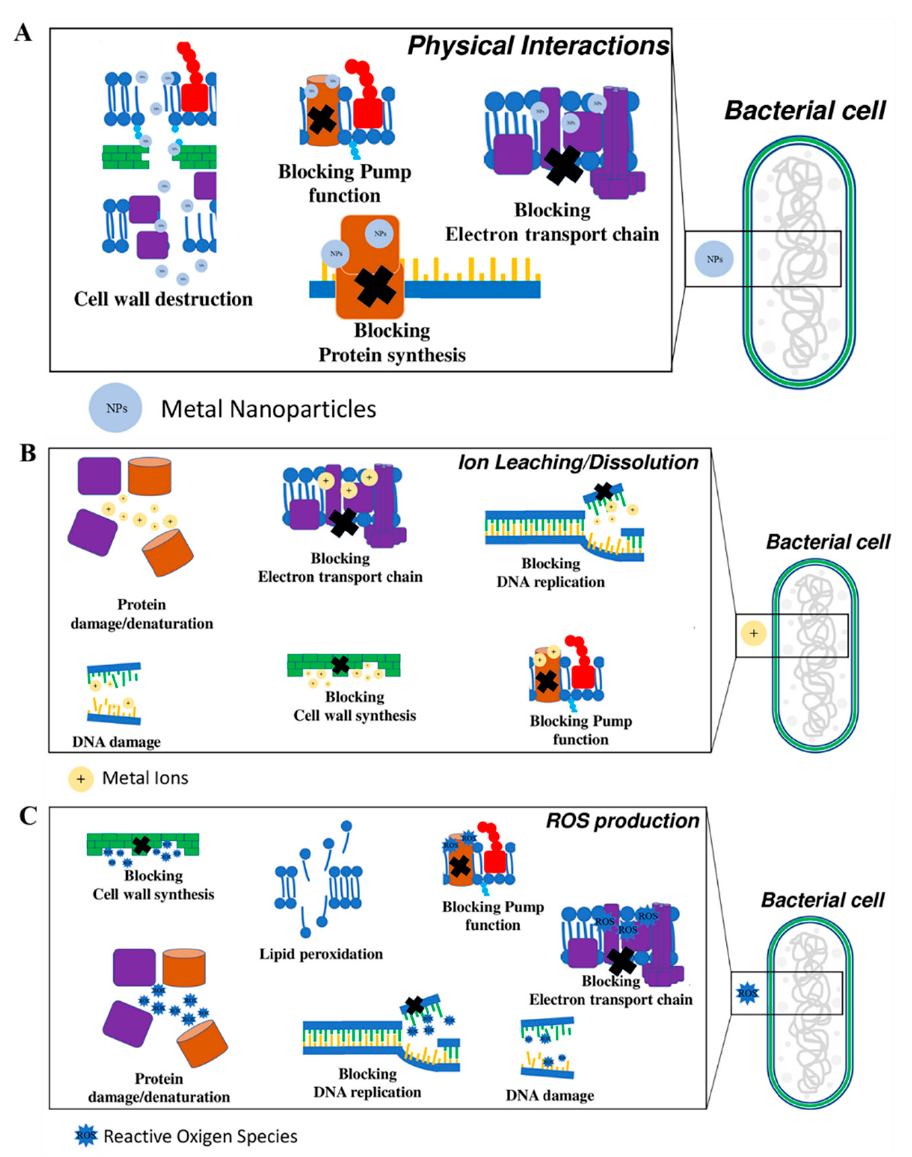
Figure 1. Schematic description of the antibacterial mechanisms of metal and metal oxide nanoparticles. ( A ) Antibacterial mechanisms due to a physical interaction mediated by nanoparticles (NPs). ( B ) Antibacterial mechanisms due to the release of metal ions ( + ) by NPs. ( C ) Antibacterial mechanisms due to the ROS produced by NPs. Reproduced with permission from ref [41], Copyright 2022 MDPI.